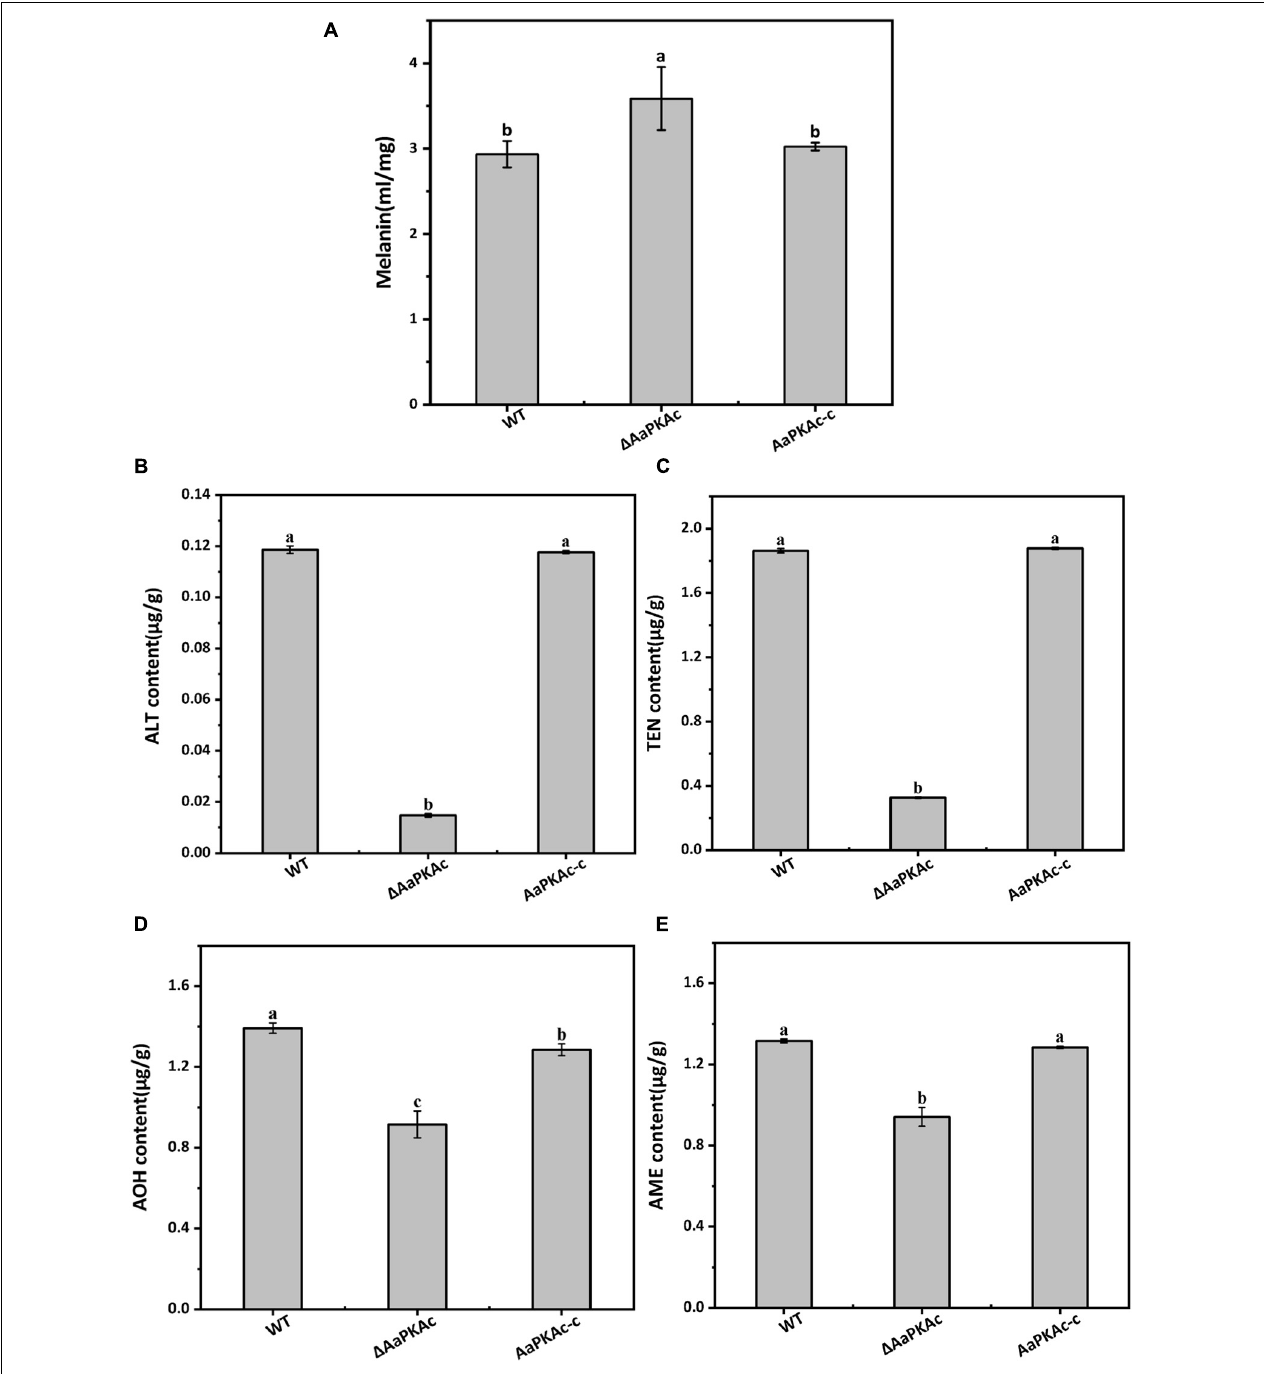
FIGURE 7 | Effect of AaPKAc on melanin and mycotoxin production. The wild-type strain (WT), (cid:49) AaPKAc mutant strain, and AaPKAc genetic complementation strain (AaPKAc-c) were cultured in PDA at 28 ◦ C for 4 days. The melanin content of the WT, (cid:49) AaPKAc mutant, or AaPKAc-c strain was detected (A) . Contents of alternariol (AOH) (B) , alternariol monomethyl ether (AME) (C) , altenuene (ALT) (D) , and tentoxin (TEN) (E) in the WT, (cid:49) AaPKAc mutant, or AaPKAc-c strain. Bars indicate the standard errors ( ± SE). Different letters denote significant differences ( P < 0.05).